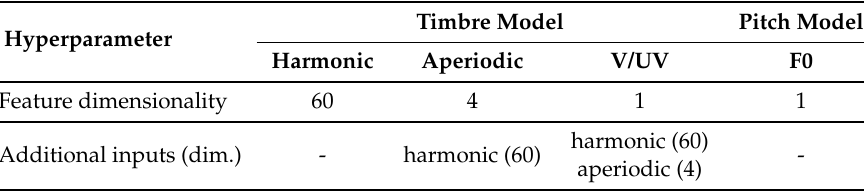
Table A1. Hyperparameters for networks based on WaveNet